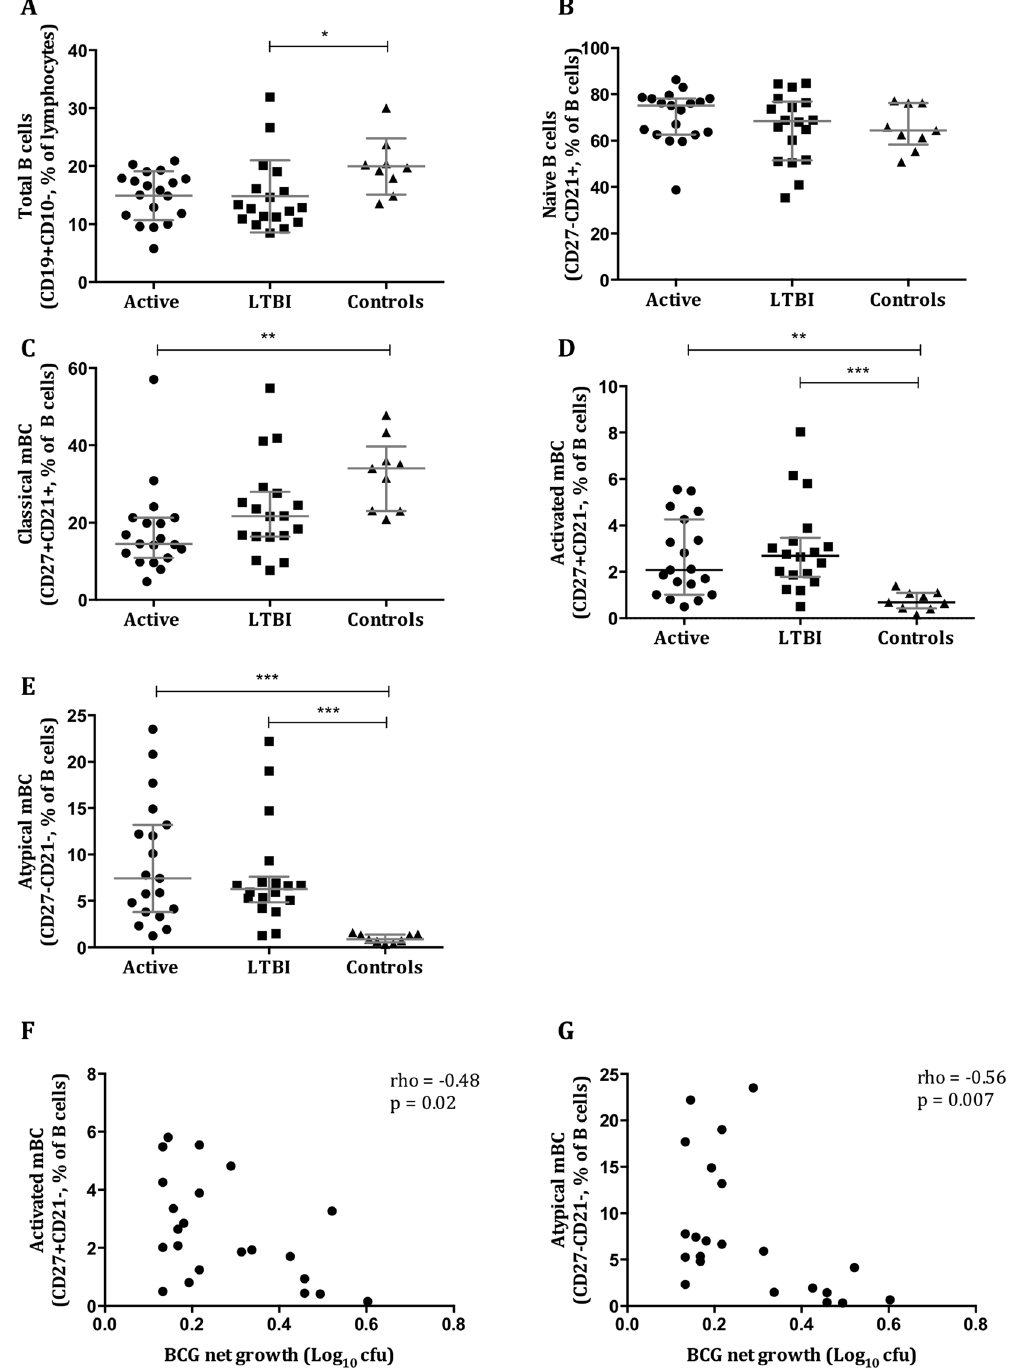
Figure 4. Increases in activated and atypical memory B cells occur in M . tb infection and correlate with improved mycobacterial control. B cell subsets were characterised among patients with active TB disease (n = 19), LTBI (n = 18) and healthy controls (n = 9) before starting anti-TB treatment. The proportions of mature ( A ), naïve ( B ), classical ( C ), activated ( D ) and atypical ( E ) B cells are shown. Negative correlations between the proportion of activated ( F ) and atypical ( G ) B cells and BCG net growth were seen. Points are single values and bars represent the median with interquartile range. After testing for normality a Kruskal-Wallis test with Dunn’s correction for multiple comparisons was performed. * Represents a p-value of < 0.05, ** a p-value of < 0.005, *** a p-value of < 0.0005 and **** a p-value of < 0.0001. Spearman’s rho and associated p-values are Serum cytokine analysis reveals discrete clusters and strong negative correlations with ex vivo mycobacterial growth. Differential levels of cytokines/chemokines may indicate immune activation and therefore we measured multiple molecules in pre-treatment serum samples (n = 133). Twenty-three analytes were